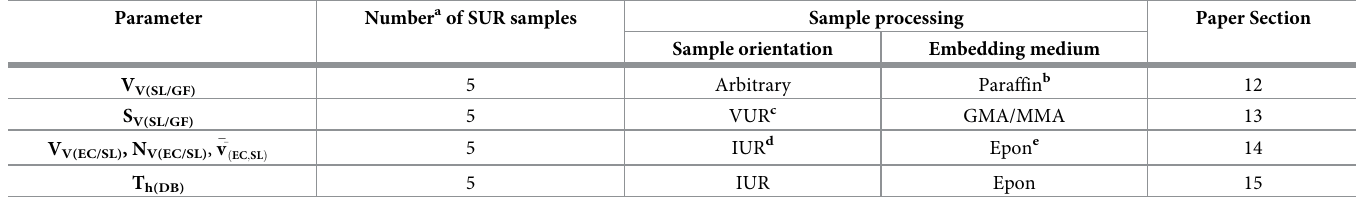
Table 3. Recommended sampling design and sample number for quantitative stereological analysis of different morphological gill